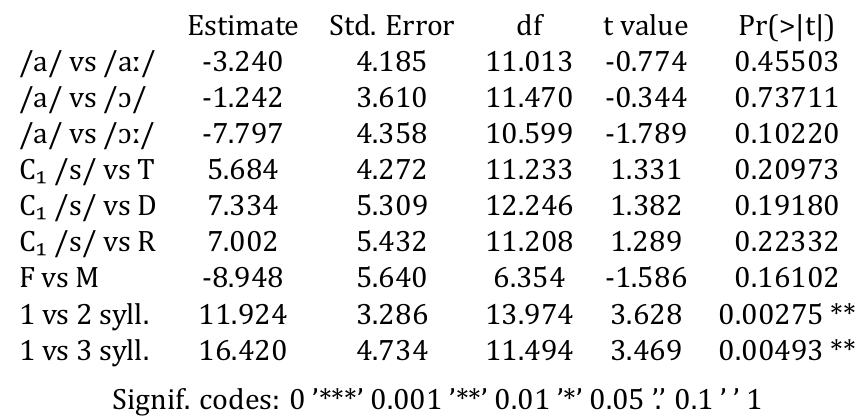
Table A.21: Breathiness duration (ms) prior to C₂ fortis plosive as a dependent